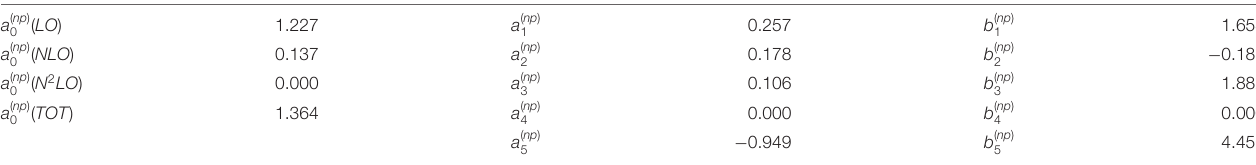
TABLE 8 | Values of the coefficients entering the expression of the section 3.4 and the N 4 LO PCTC potential derived in Entem et al. [18] at vanishing neutron beam energy.